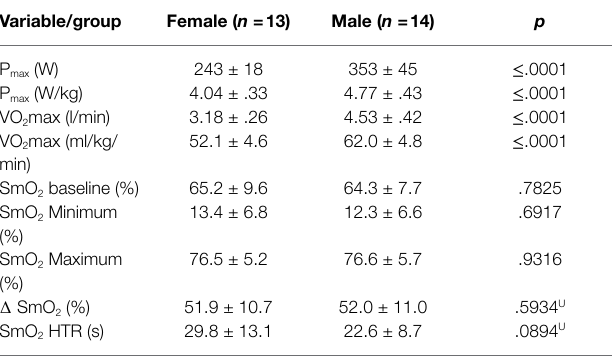
TABLE 3 | Values of selected indices recorded during the graded exercise test in the examined group of female and male speed skaters ( n = 27), mean ± SD.